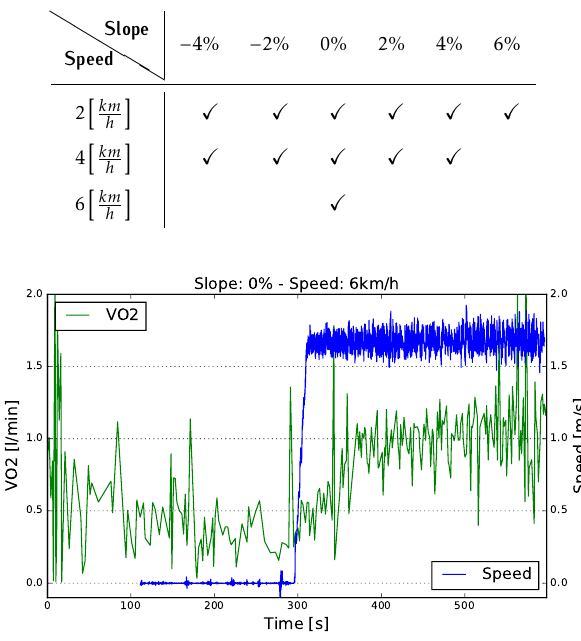
Table 3. Description of the three subjects who participated in the treadmill experiments. Age is expressed in years, weight in kilograms and height in centimetres Age Weight